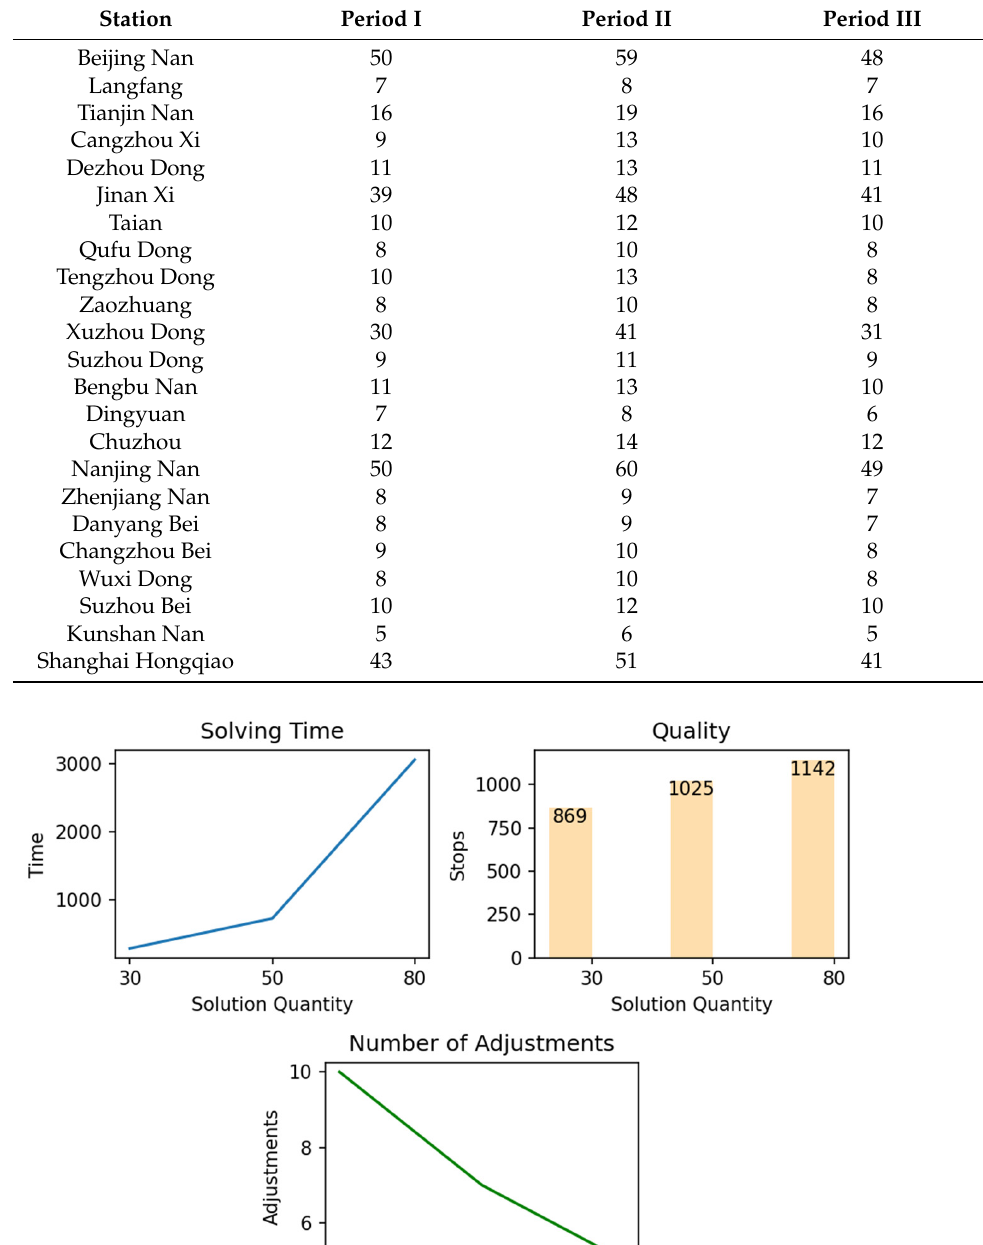
Table 9. Time-dimension decomposition result.